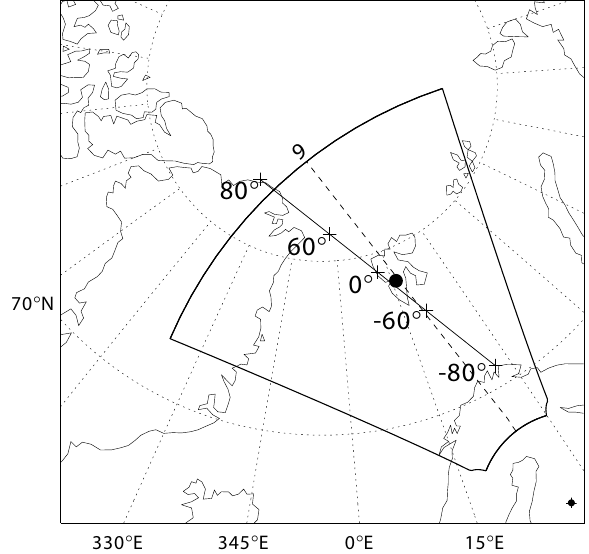
Fig. 1. Geographic map showing the location of the ESR (black cir- cle), the meridian scan path of the MSP located at Ny ˚Alesund pro- jected to an altitude of 250km (solid black line) and the CUTLASS Finland radar f-o-v (grey shaded area). The dotted line represents the path of beam 9 of the Finland radar which passes over the